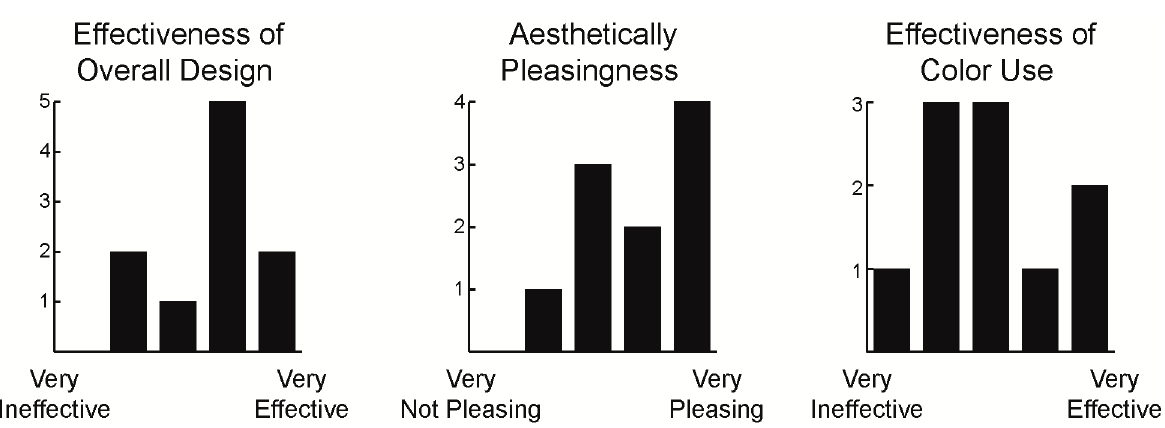
Figure 11. Ratings on SPoTvis’ design ( left ), aesthetics ( middle ) and use of color ( right ). Each graph depicts the frequency of response on a five-step Likert scale with the end points labeled using the terms shown below the